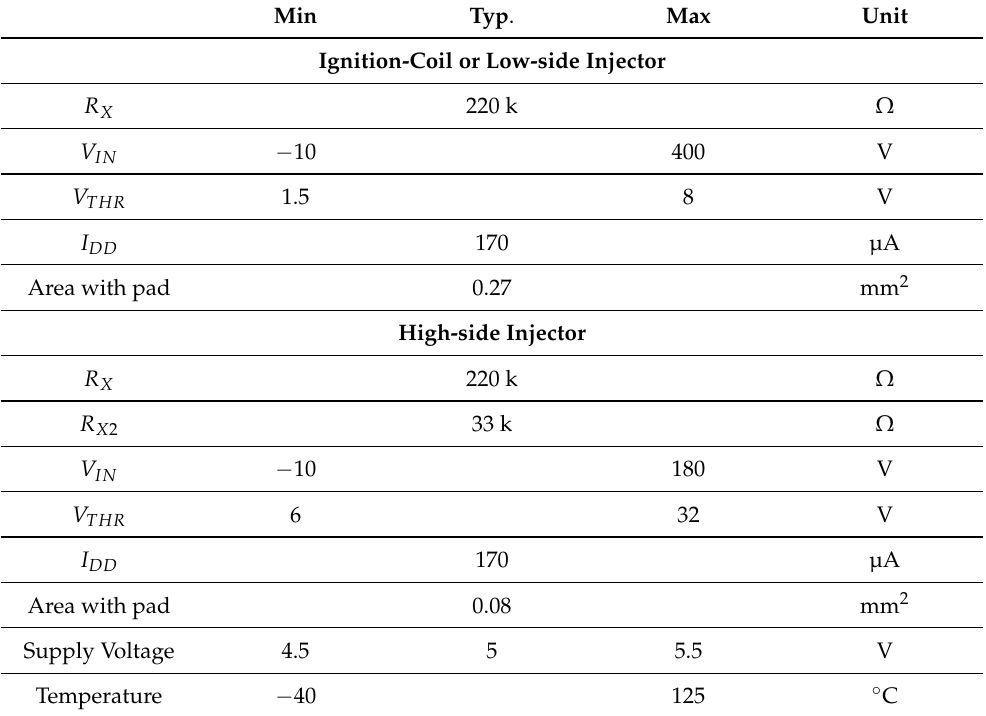
Table 1. Specifications of interface